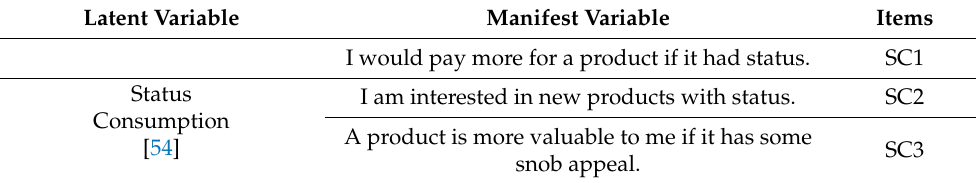
Table 4. The mediator variable “status